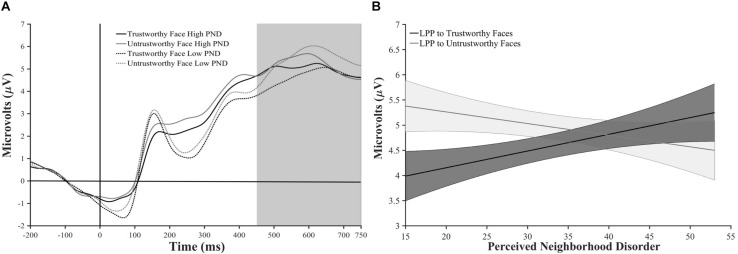
(A) Average ERP waveform at electrode CP4, where LPP mean amplitude was maximal for individuals low and high on PND total score. Primary analyses were conducted using continuous PND scores, and “low PND” (individuals who scored below the mean on the PND variable) and “high PND” (individuals who scored above the mean on the PND variable) groups were created solely for ease of visual representation of results. Dashed lines represent the low PND group, and the solid lines represent the high PND group. The black lines represent trials where the face was rated as trustworthy, and the gray lines represent trials where the face was rated as untrustworthy. The gray box indicates the timeframe (450–740 ms) used to derive the LPP mean amplitude measure. (B) Regression lines represent LPP amplitude to trustworthy and untrustworthy faces as a function of perceived neighborhood disorder (PND total; lines represent scores at ±1 SD from the mean). Error bands indicate 1 SE.